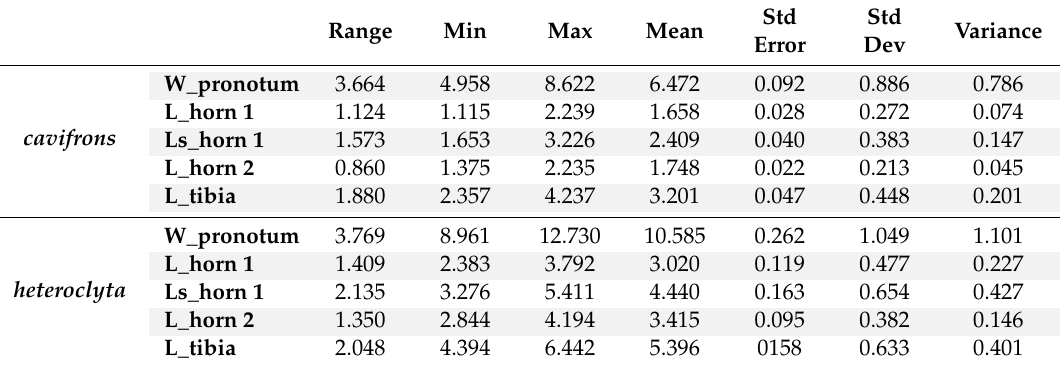
Table 1. Descriptive statistics of linear measurements in the males of both Anomiopsoides species. Range Min Max